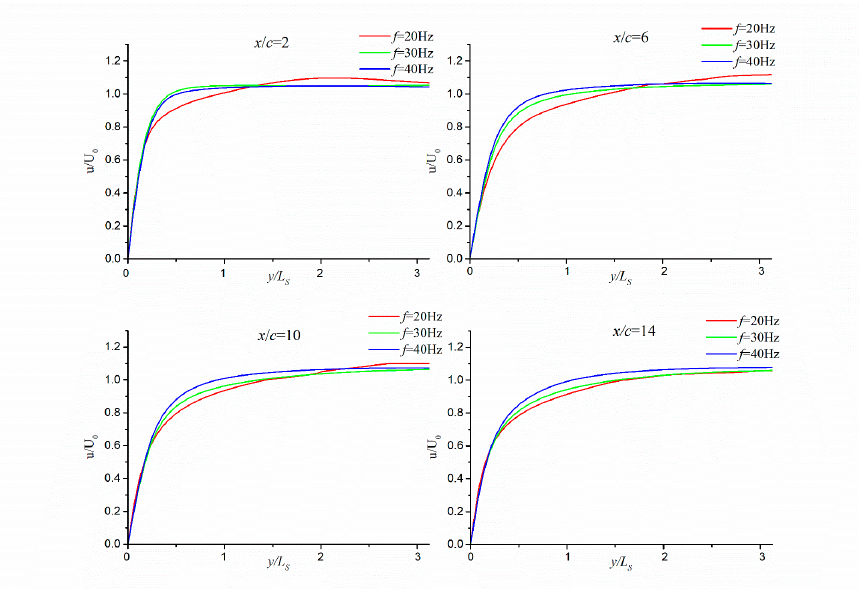
ff erent rotor-stator interaction